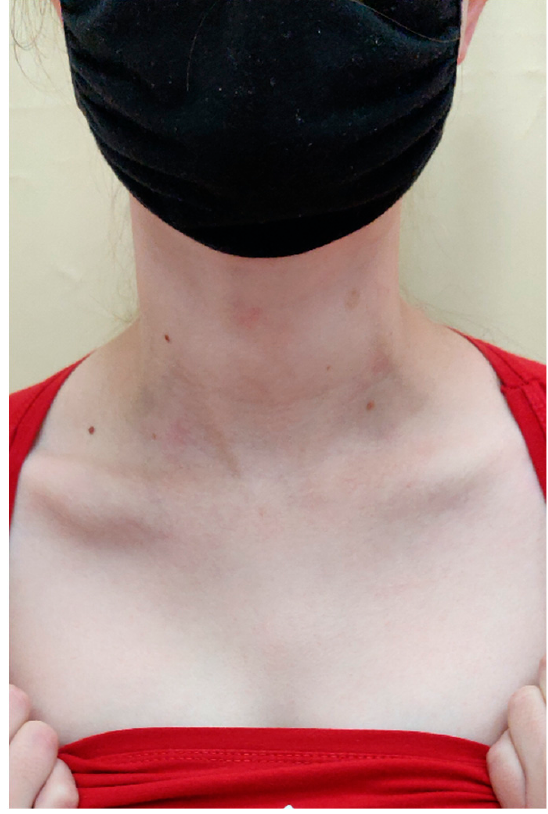
Figure 14. The right scapula on the last day of hospitalisation.